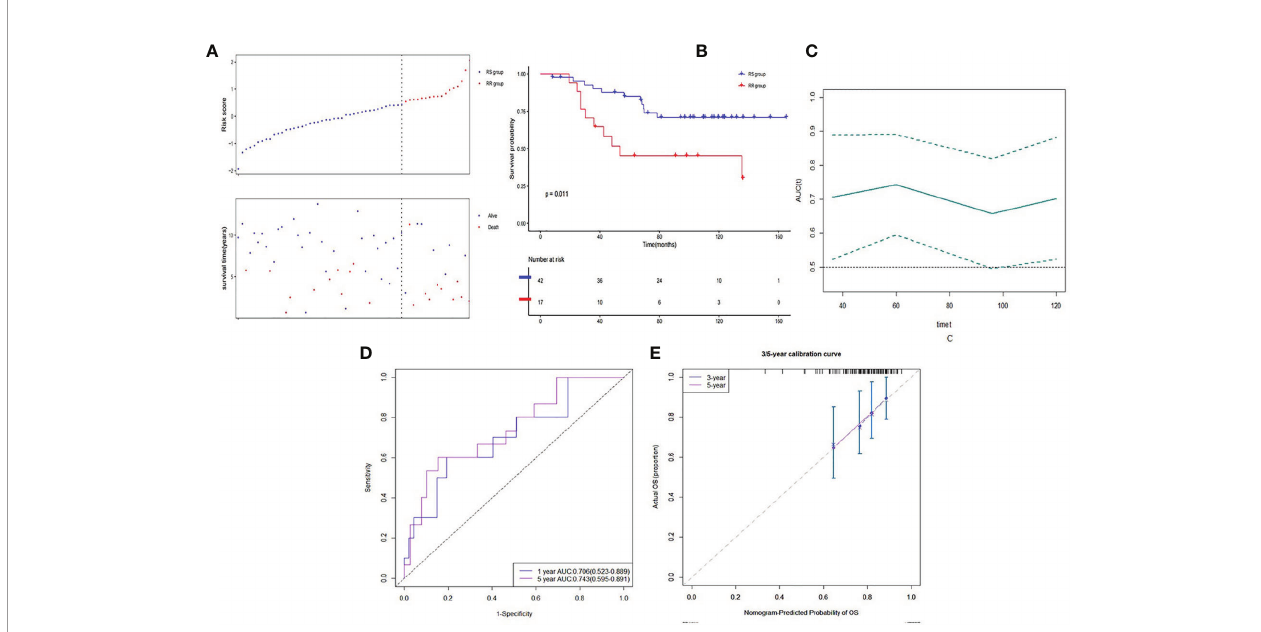
FIGURE 5 | Discrimination ability of gene signature in validation dataset. (A) Low risk score group and high risk score group based on the cutoff value of risk score. (B) K – M curve of comparison for the RS and RR groups. (C) Time-dependent AUC of the risk score. (D) The 3- and 5-year AUC of the risk score. (E) Calibration plot for 3- and 5-year AUC of the risk